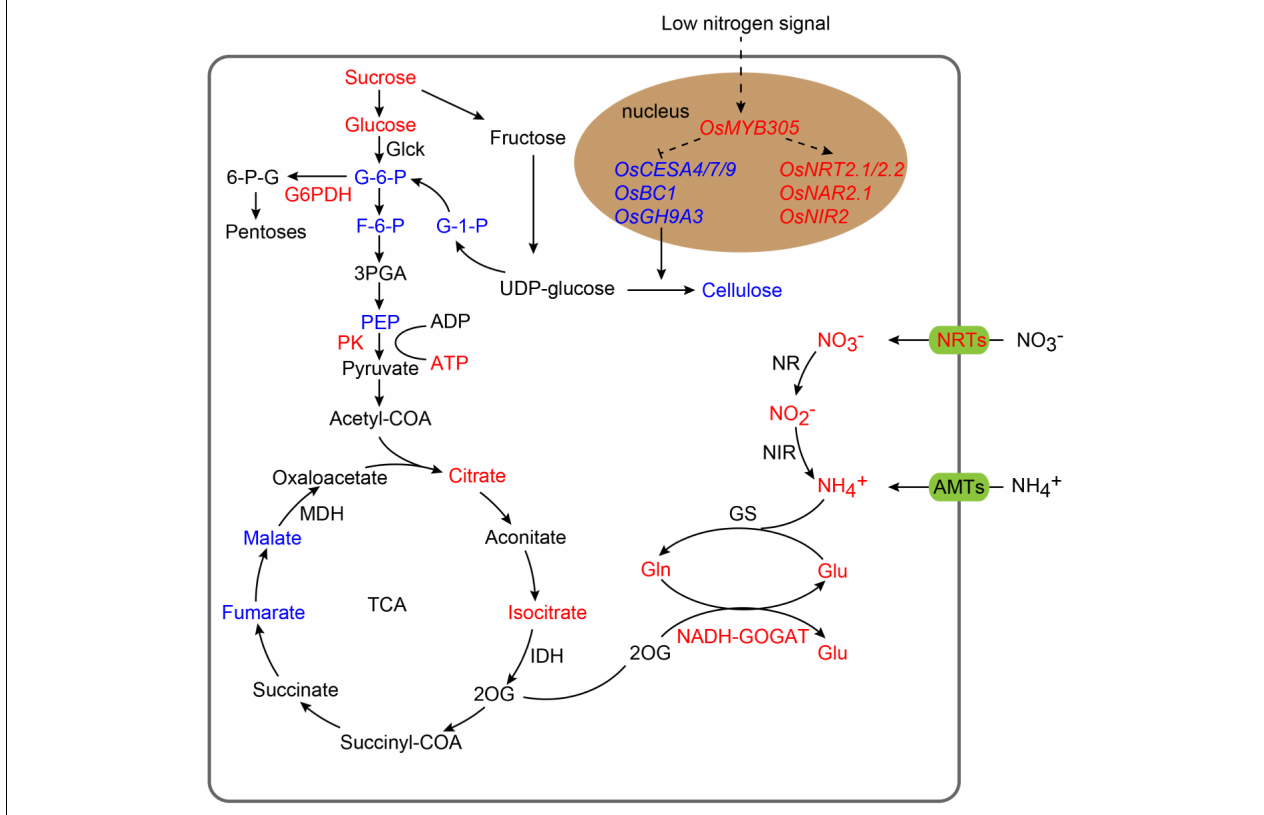
FIGURE 9 | The integrated schematic diagram of the changes on gene expression, metabolism and enzyme activities in OsMYB305 -OE lines. Increased objects were represented by red letters; decreased objects were represented by blue